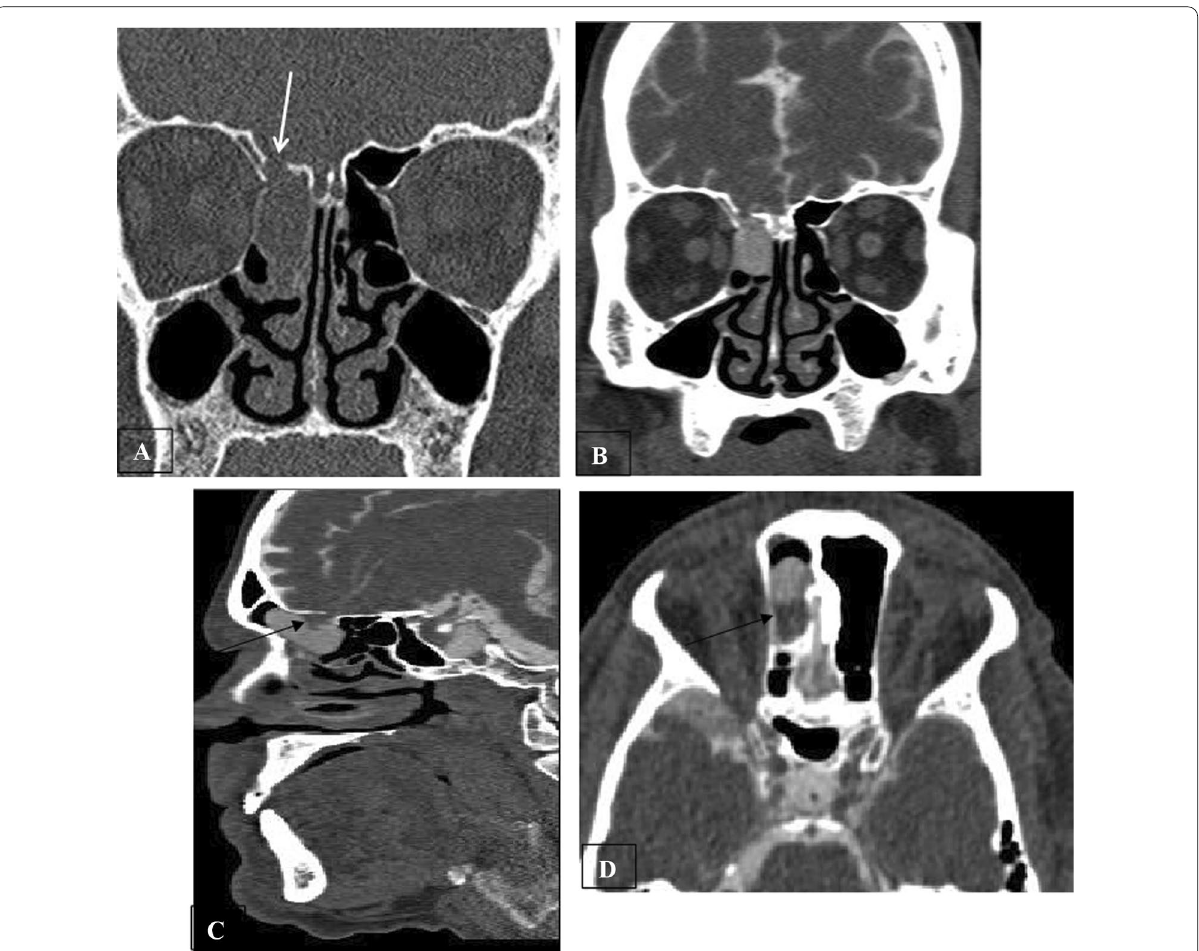
Fig. 4 Non-contrast CT in coronal ( A ), CT cisternography in coronal ( B ), sagittal ( C ) and axial ( D ) planes show defect measuring 6 mm in the roof of the right ethmoid sinus (white arrow) ( A and B ) with evidence of contrast leak through this defect in addition to herniated brain tissue from the right frontal lobe (black arrow) ( C and D